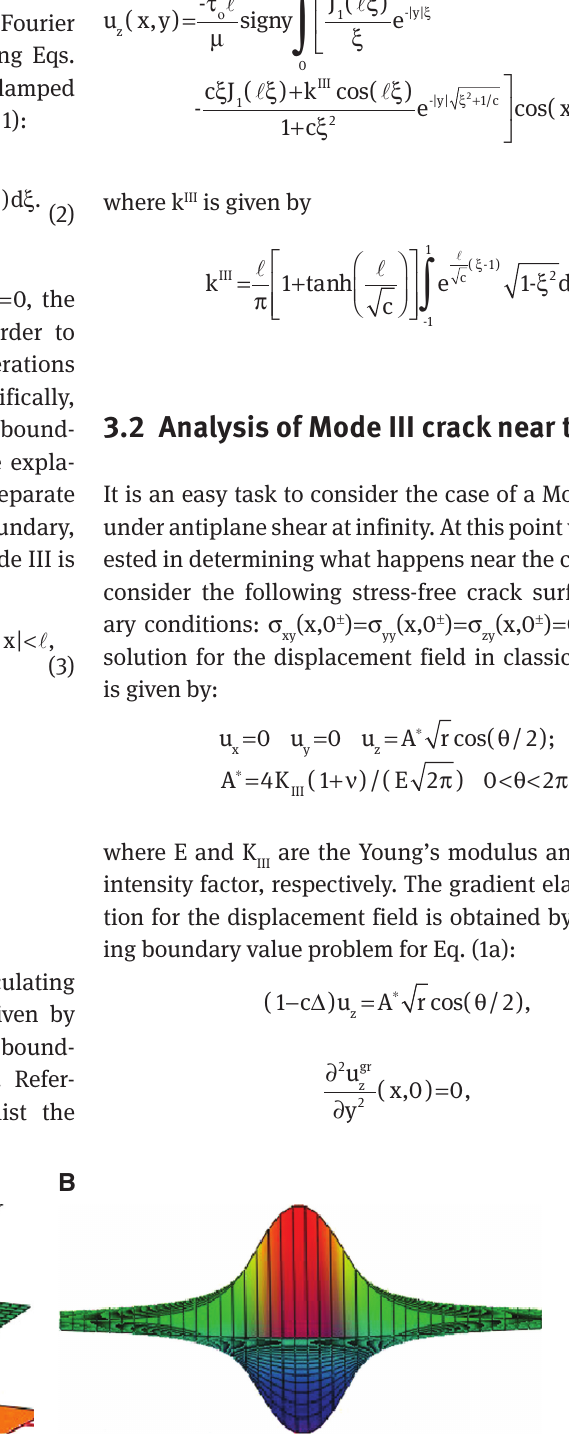
Figure 1 (A) Plot of Eq. (2) for τ